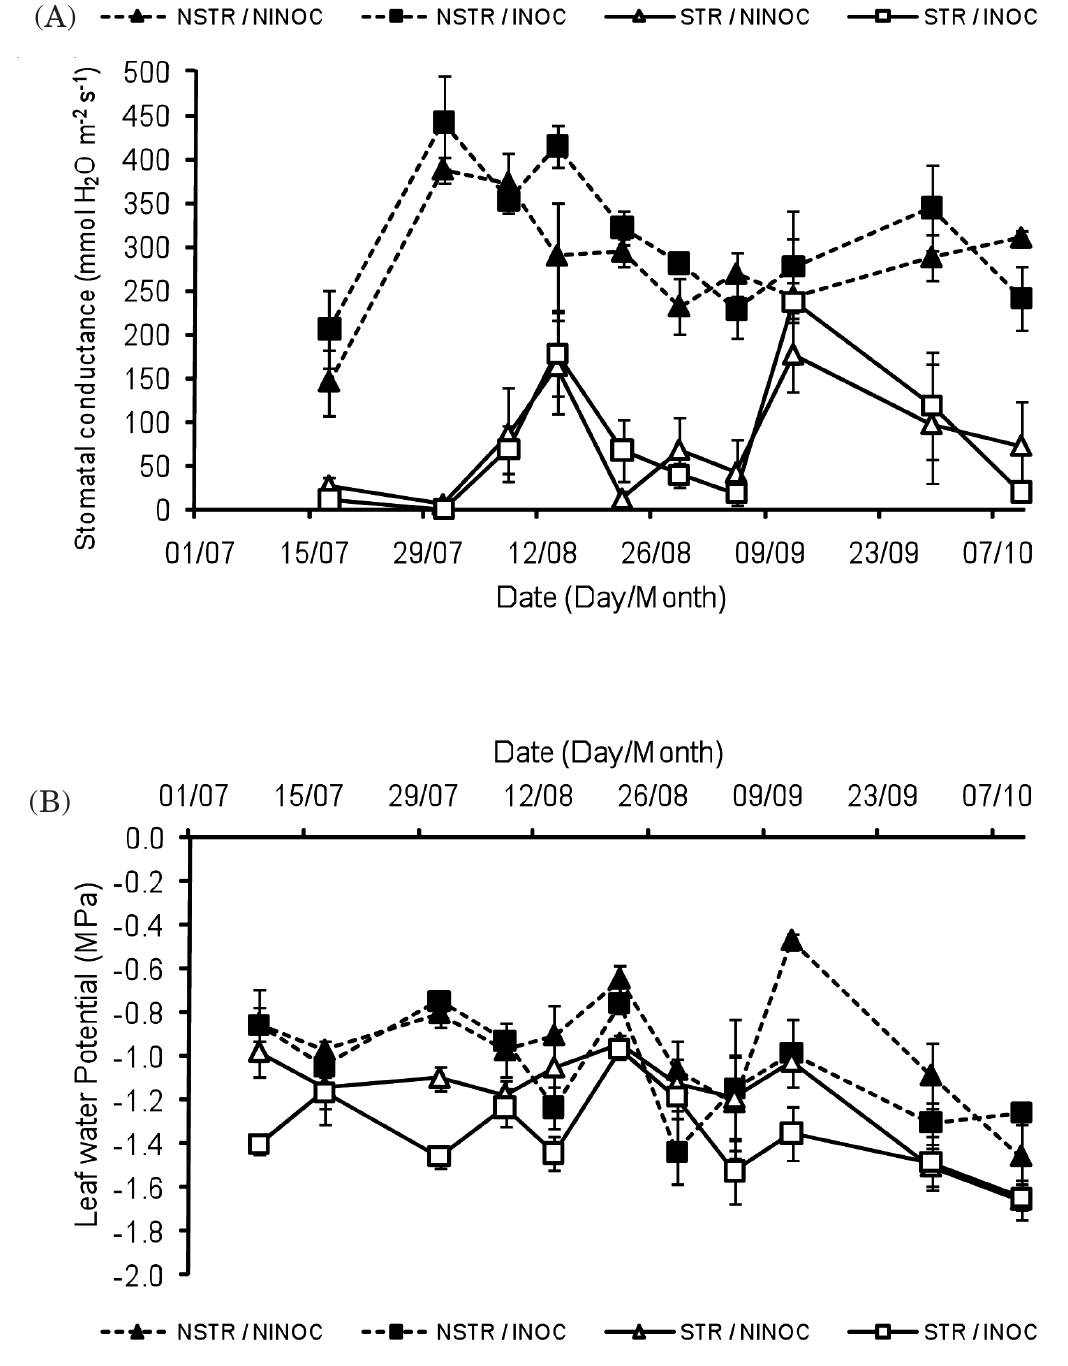
Figure 2. Stomatal conductance (A) and leaf water potential (B) data for one-year old grapevines ( Vitis vinifera cv. Tempranillo) inoculated with Eutypa lata or left uninoculated and subjected to one of two watering regimes. INOC, inoculated with E. lata ; NINOC, non-inoculated, STR, water-stressed, NSTR,